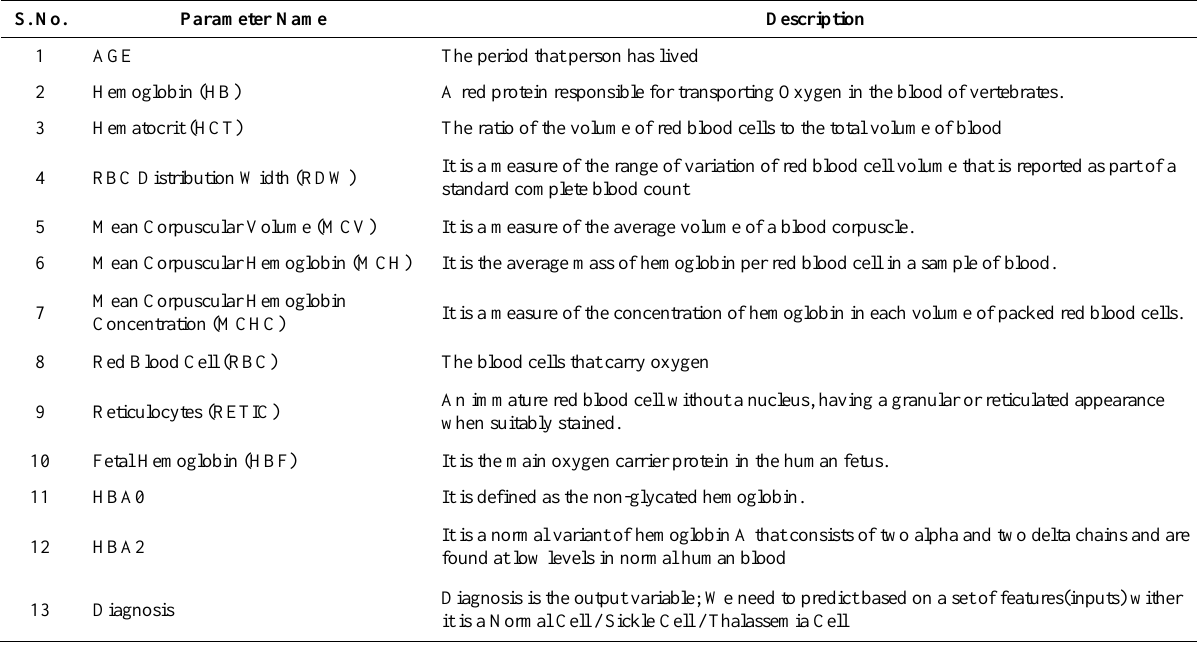
Table 2. The 13 parameters present in the dataset with an